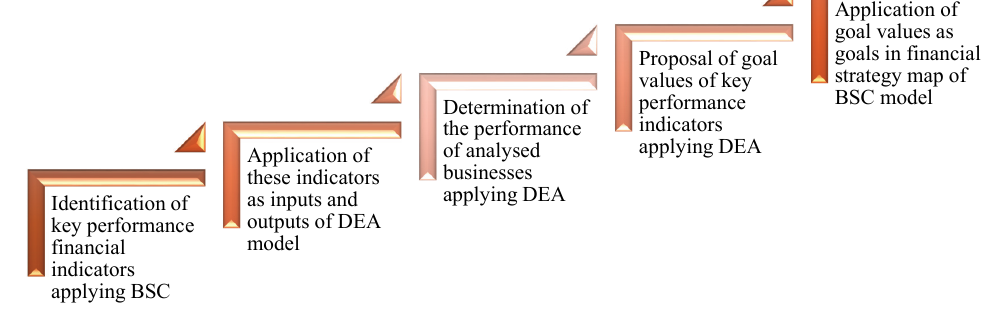
Fig. 1. Flowchart of the